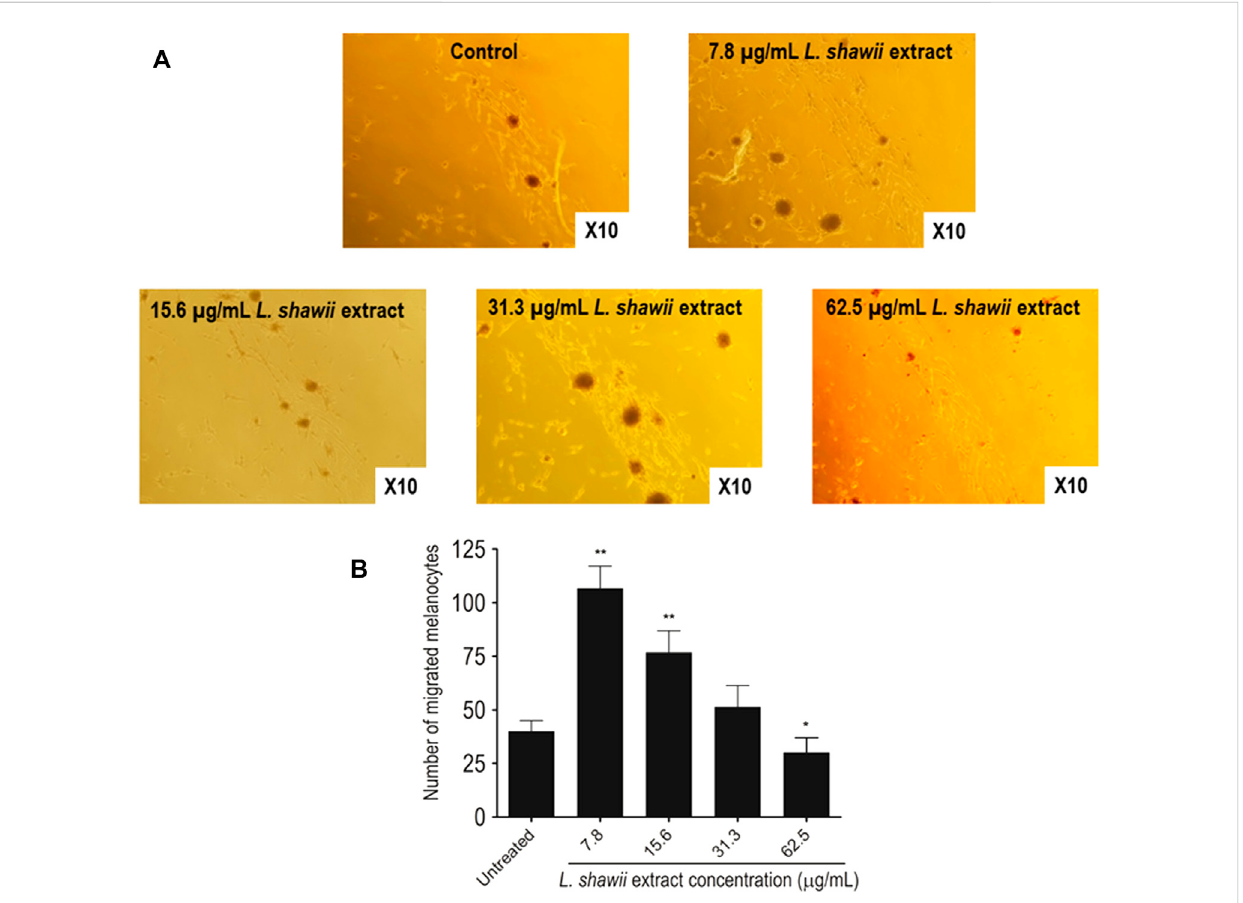
FIGURE 3 Modulatory effects of various concentrations of L. shawii extract on primary human melanocyte migration using the scratch wound-healing assay. (A) Representativephotomicrographsshowingmelanocytemigrationcoveringthescratchwoundareaafter72 hofincubationinthepresenceofvarious concentrations (7.8 – 31.3 μ g/mL) of L. shawii extract, compared with the control, the untreated cells. (B) The bar graph indicates the number of migrated melanocyte and the results are presented as mean ± SD of three independent experiments. * p ≤ 0.05 and ** p ≤ 0.01 signify a statistically signi fi cant difference compared with the